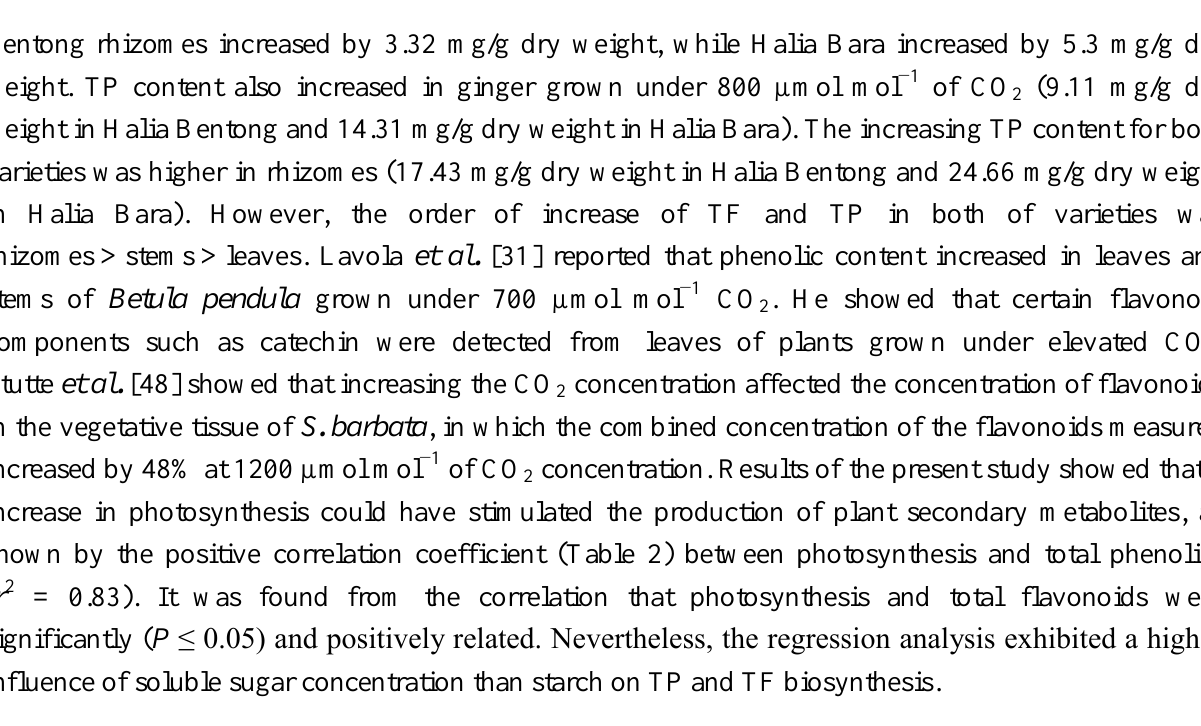
Table 5. Total phenolic and flavonoid contents of the methanol extracts in different parts of two varieties of Z.